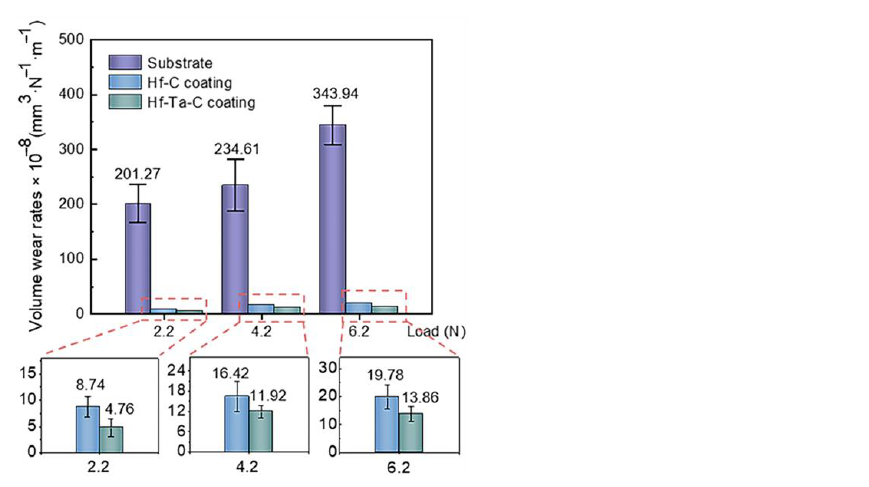
Figure 13. Volume wear rates of coatings and the substrate.